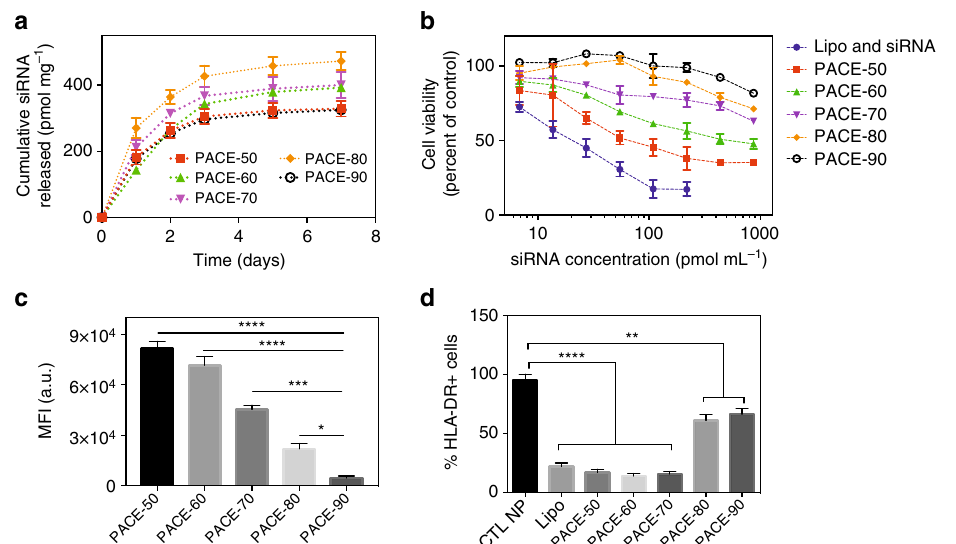
Fig. 2 NP transfection and toxicity in HUVECs. a siRNA-loaded PACE-50, 60, 70, 80, 90 nanoparticles were incubated in PBS at 37 °C for up to 7 days. At each time point, PBS containing released siRNA was sampled and siRNA concentration was quanti fi ed using the PicoGreen Assay. b HUVECs were treated with siRNA PACE nanoparticles or lipofectamine (7 – 900 pmol mL − 1 ) for 24 h, after which cells were washed and cell viability was quanti fi ed using CellTiter-Blue Assay (Promega). c HUVECs were treated with DiD-loaded PACE nanoparticles for 6 h and nanoparticle association was quanti fi ed using fl ow cytometry. d Knockdown of HLA-DR (the highest expressed form of MHC II) protein on HUVECs was quanti fi ed using fl ow cytometry. HUVECs were treated with PACE nanoparticles (30 nM) or lipofectamine (30 nM). After 6 h, transfection agents were removed and cells were cultured in medium containing hIFN- γ for another 72 h. Data shown is mean ± SD ( n = 4). ** p < 0.01, *** p < 0.001, **** p < 0.0001 by one-way